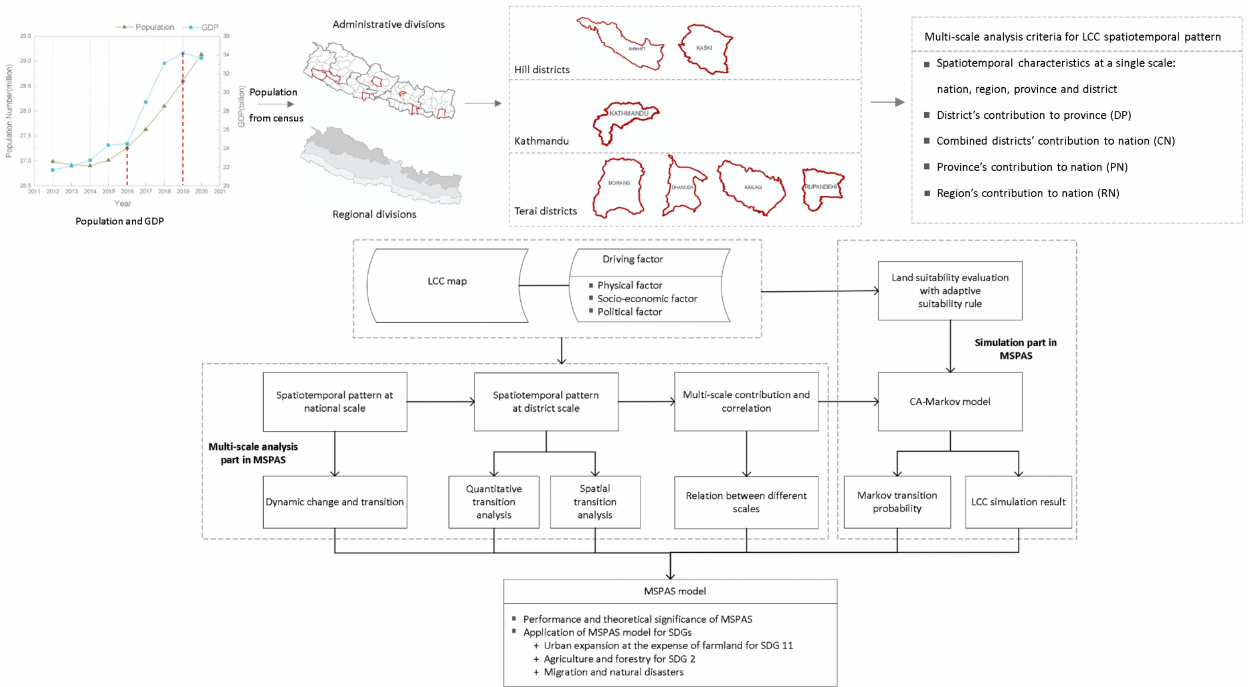
Figure 3. Flowchart of MSPAS